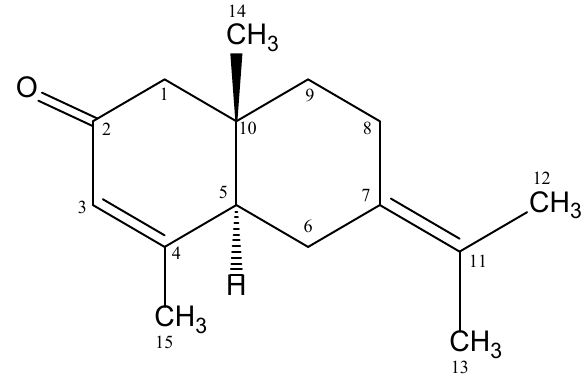
H-5 to H -6 (δ 5.861.92/2.251.71/2.86); ii) H -8 to H -9 2 H 2 2 (δ 1.94/2.551.32/1.52); iii) H -1 (2.13 2.24, AB system) H 2 ( Figure 2 ). Based on the HMBC correlations, positions of the spin systems, quaternary carbons and methyl groups were established ( Figure 4 ). Firstly, the α,β-unsaturated ketone system was located at C-2/C-3/C-4 of the ring A based on the key HMBC’s from C-2 (δ 198.9) and C-5 to H -1, 2 from C-5 (δ 48.3) and C-15 (δ 21.8) to H-3 (δ 5.86), and C-3 (δ 126.9), C-4 (δ 163.0) and C-5 to H -15 (δ 1.92). The second 3 olefinic system with tetrasubstitution pattern was located between C-7 and C-11 due to 3 J long-range correlations C-H from C-7 (δ 129.5) to H -12 (δ 1.67) and H -13 (δ 1.69), and 3 3 from C-11 (δ 123.0) H -8 (δ 1.94 and 2.55) and H -6 (δ 1.71 2 2 and 2.86). Additionally, the position of the methyl group resonated in the up-field (δ 0.93) was assigned to CH -14 3 on the basis of the long-range correlations from C-1, C-5 and C-9 to H -14 ( Table 5 ). 3 The relative stereochemistry of 1 was resolved by the 2D-NOESY spectrum. The cross nOe peaks between H -14 3 (δ 0.93) and H-1 (δ 2.24), and from the other H-1 proton eq